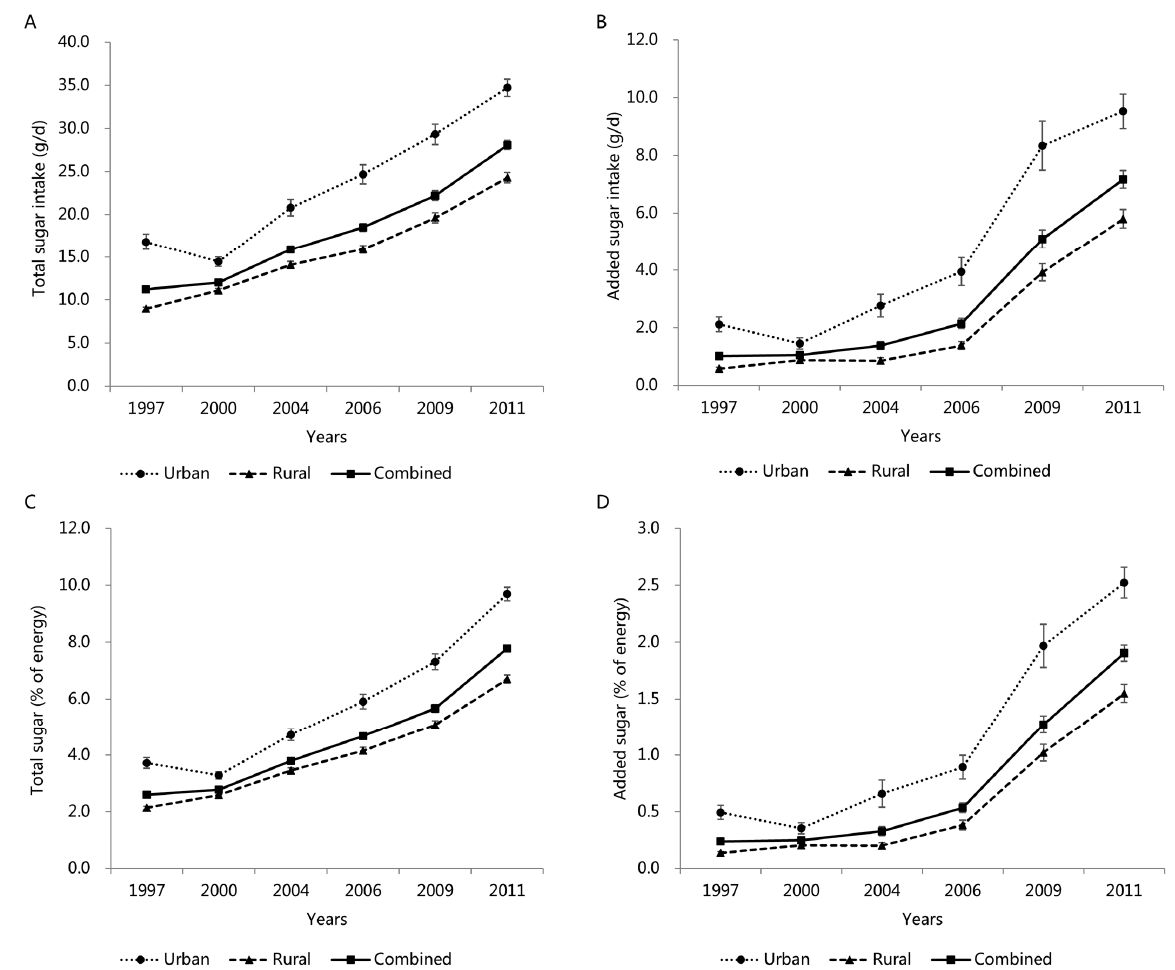
Figure 3. Mean (±SE) trends in total sugar intake ( A ), added sugar intake ( B ), total sugar (%E) ( C ), and added sugar (%E) ( D ) in Chinese children and adolescents by area, CHNS 1997–2011. All results